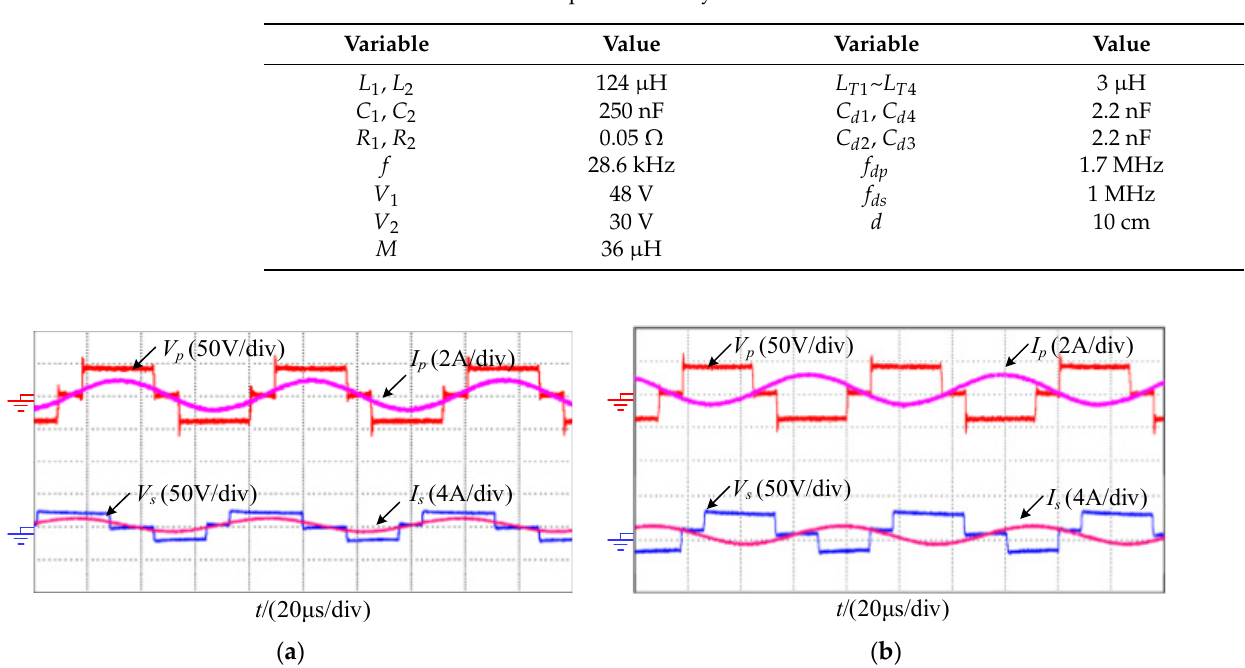
Figure 12. Experimental setup. Table 1. Parameters of The Proposed WPT System.